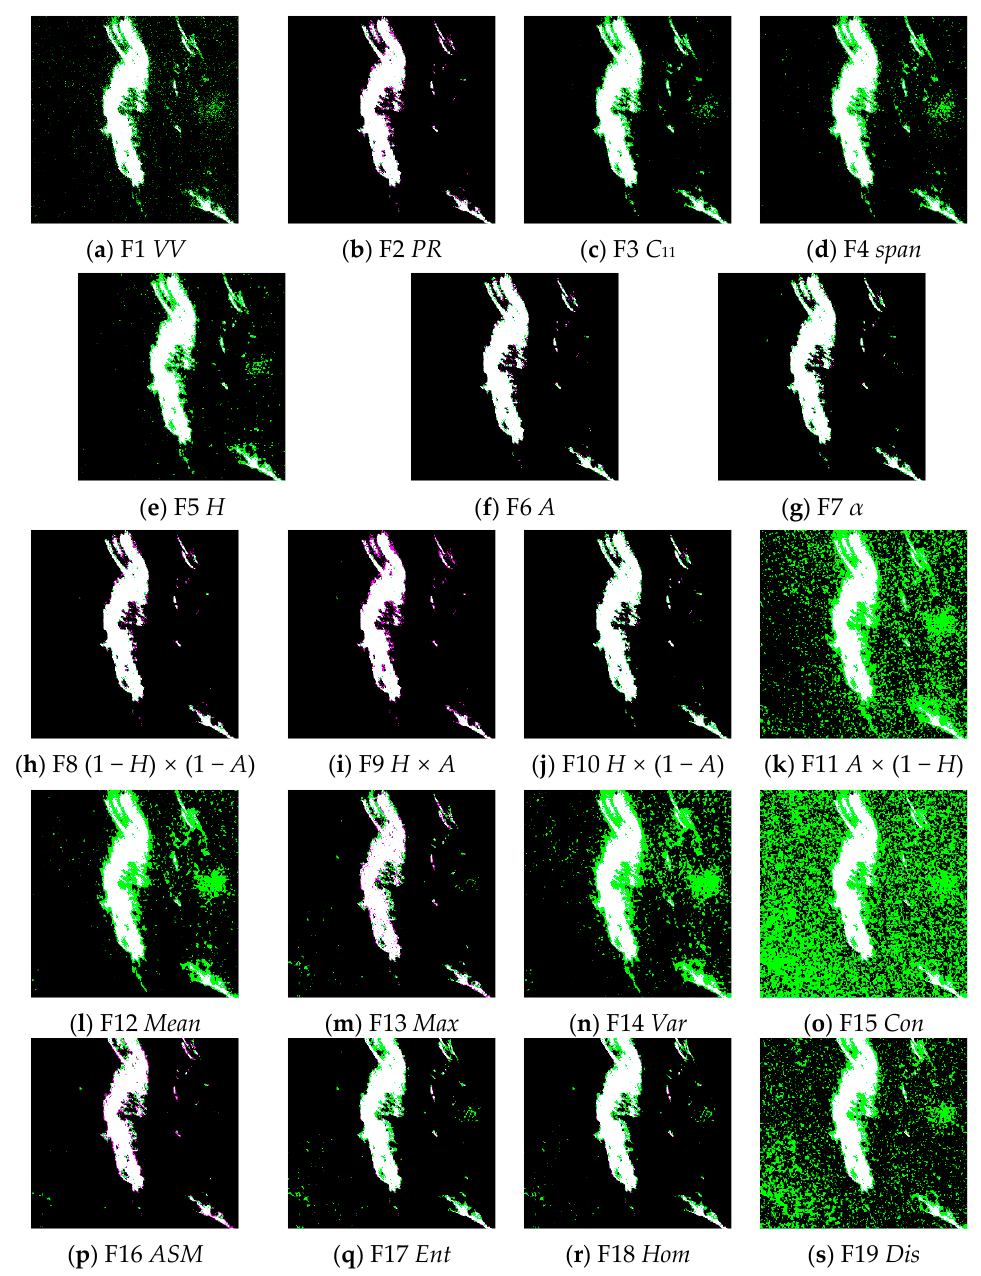
Figure 15. Evaluation results for data b based on K-means algorithm.